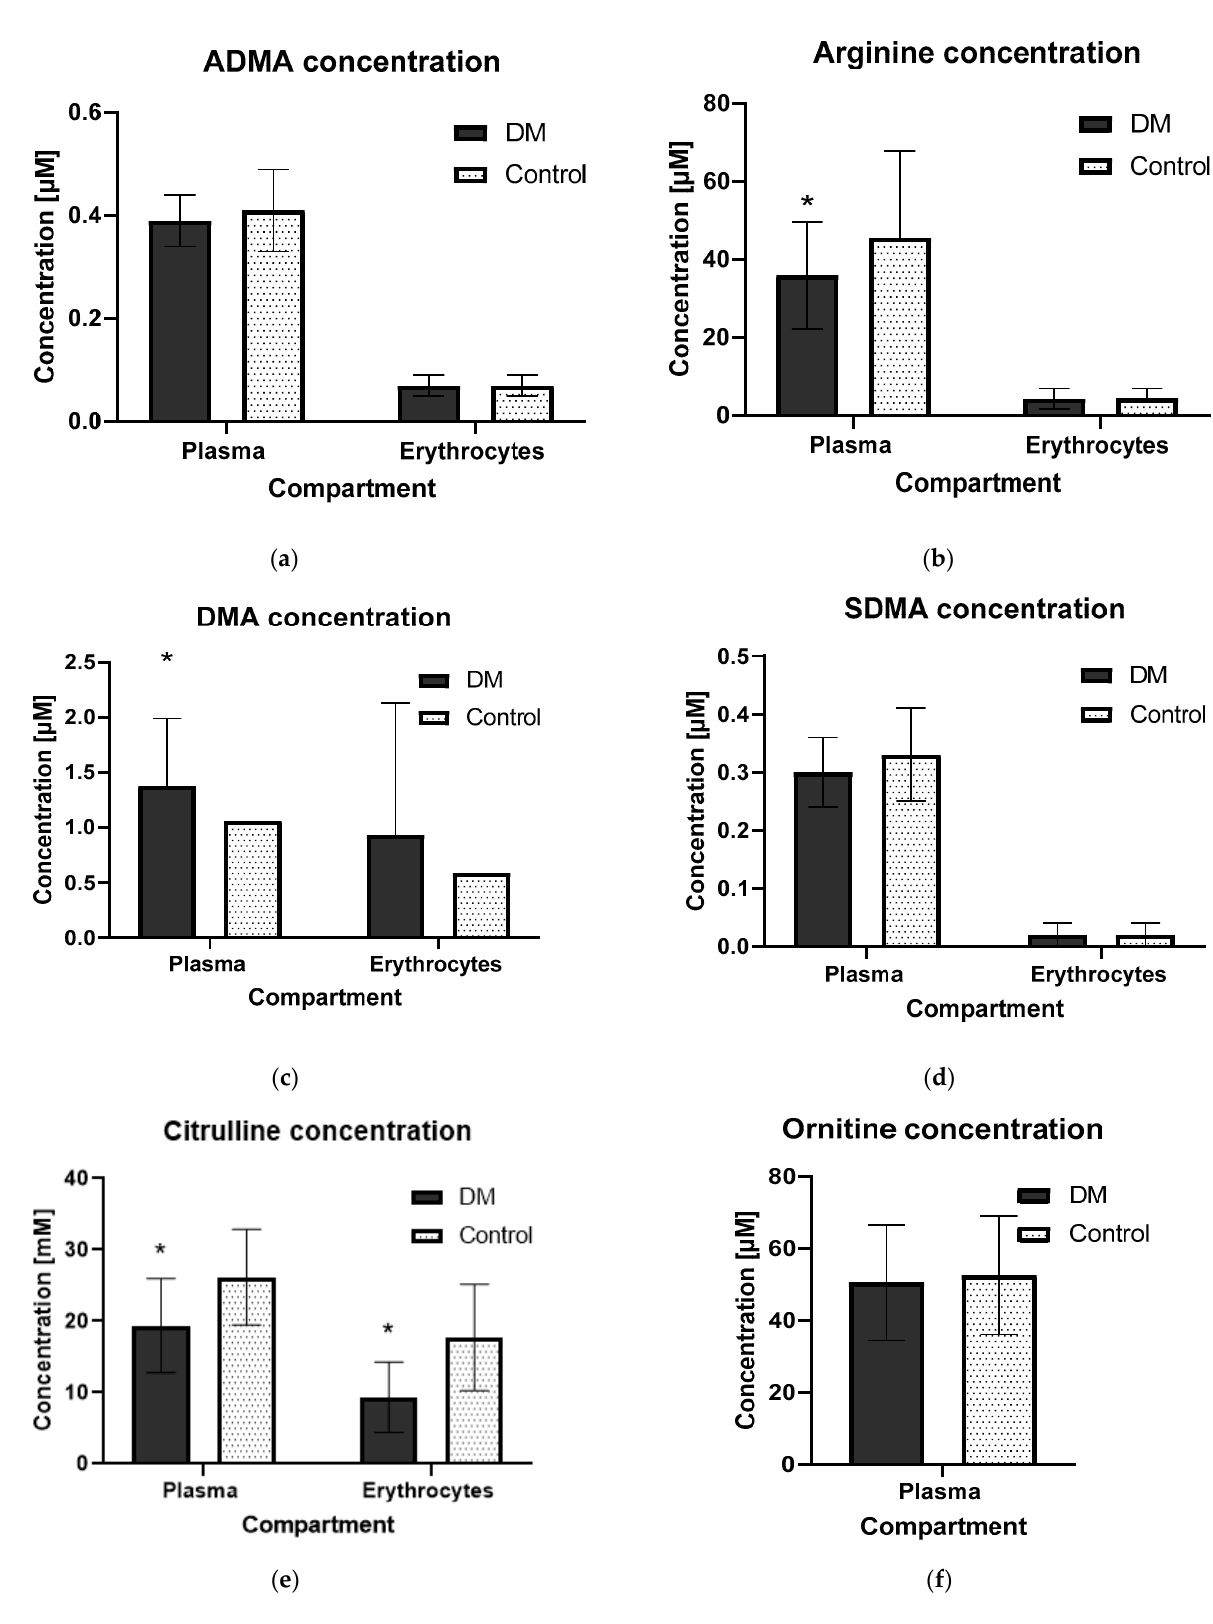
Figure 2. ( a – f ) Nitric oxide metabolites concentration in different compartments. *- p < 0.05 vs. control.